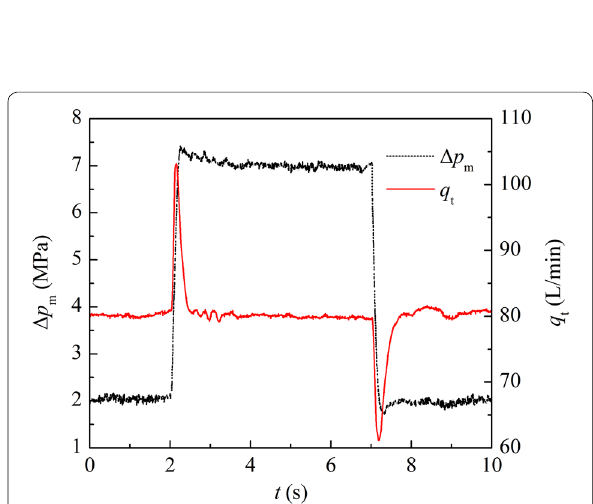
Figure 14 Flow through the developed valve at abrupt change of the load pressure